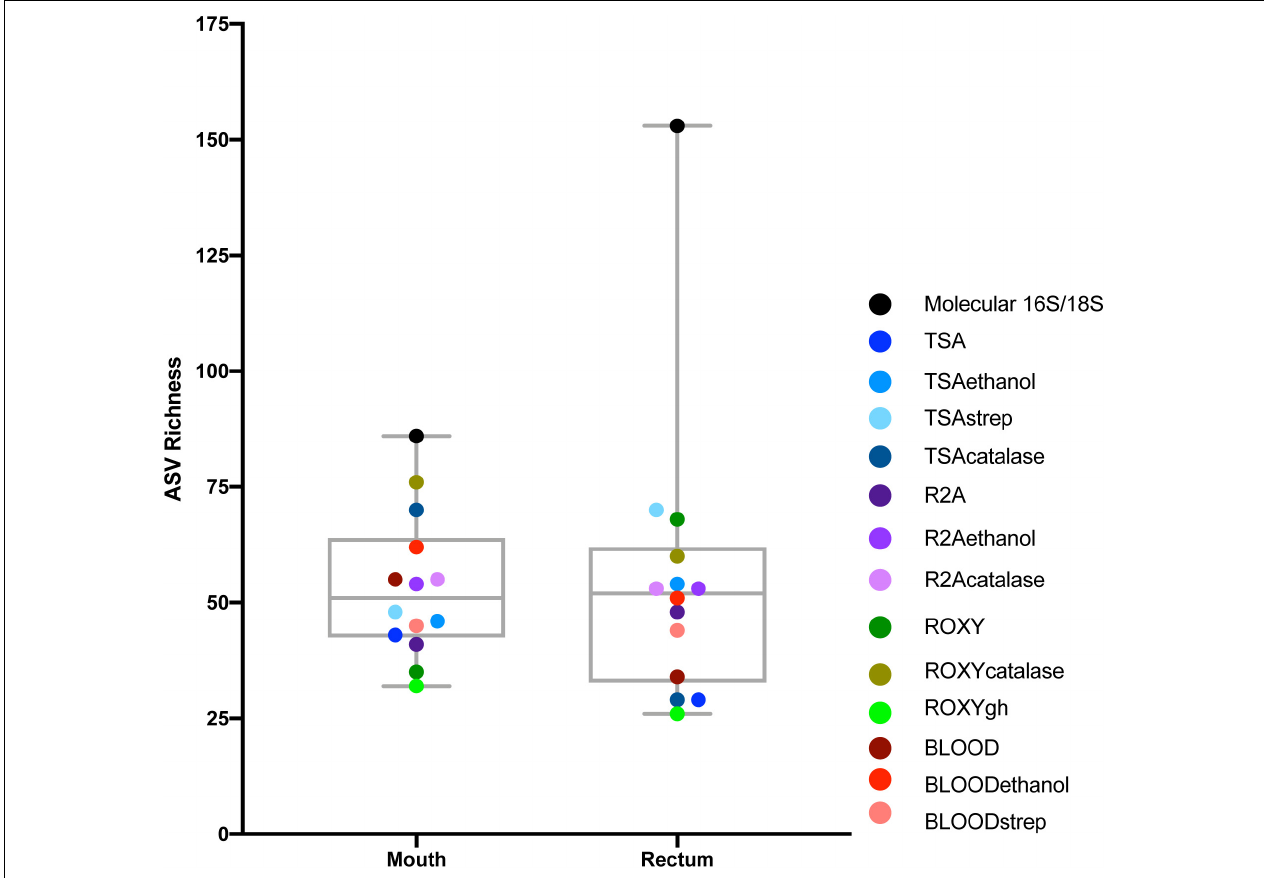
FIGURE 1 | Alpha diversity of the mouth and rectum. For the controls, richness, measured using ASVs, was higher in the rectum than the mouth. For cultivated communities, richness varied based on medium type and treatment. Points represent each medium or treatment type, indicated by color ( n = 3). Molecular 16S/18S refers to the directly sequenced inoculum sample ( n =